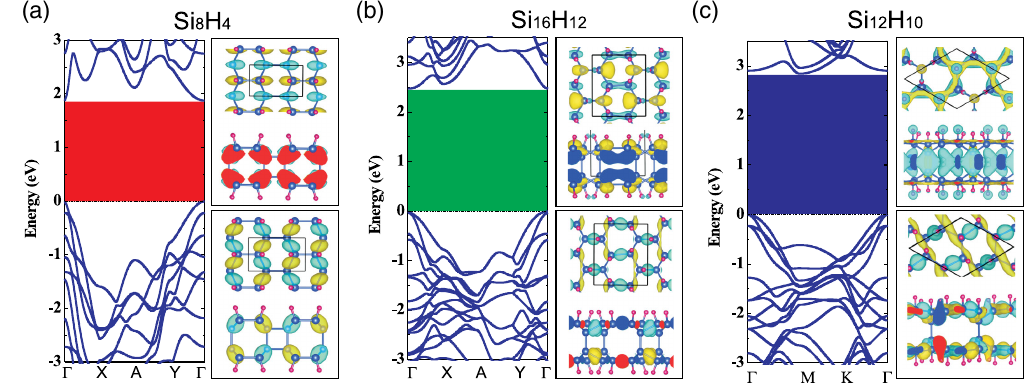
FIG. 9. The calculated band structures of double-sided (a) Si 8 H 4 , (b) Si 16 H 12 , and (c) Si 12 H 10 . The wave functions of VBM (bottom figure) and CBM (top figure) at the Γ point for each structure are also plotted here. The color for each band gap is also shown. The Fermi level is set to zero.